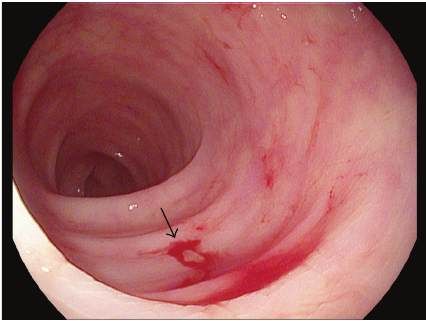
Figure 3: Application of hemostatic endoclip to colonic Dieulafoy’s lesion after bipolar cautery, achieving